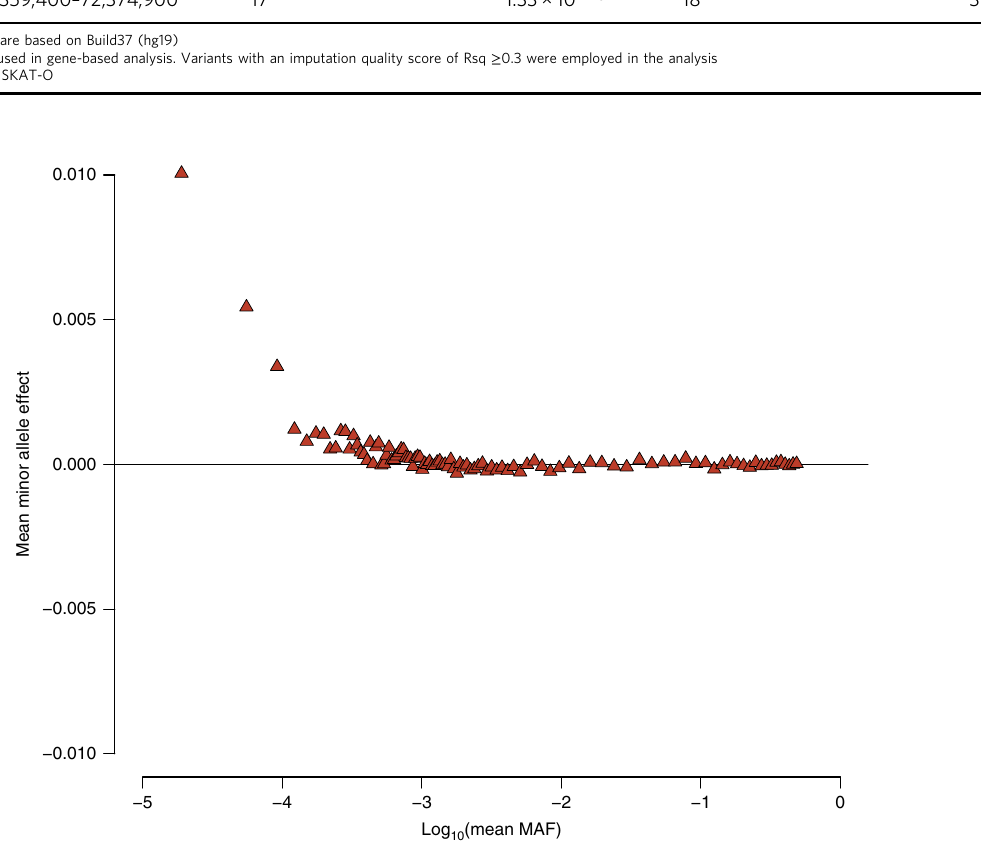
Fig. 4 Relationship between the minor allele effect for height and MAF in the GWAS. A scatter plot of the mean minor allele effect according to each MAF bin ( N = 100) is shown. The mean effects of the minor alleles were clearly greater in rarer